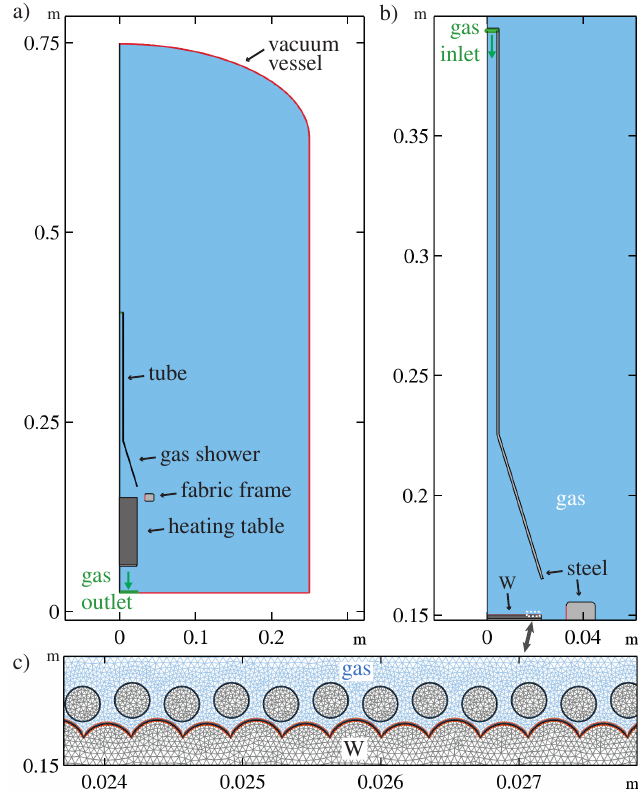
Figure 5. ( a ) Reactor model geometry of the CVD device with a close-up of the gas shower in ( b ) and with a closer look at the fibers of the new layer (floating circles) in ( c ). Below the fibers, the W domain is shown, which consists of the fibers from the previous layer and the CVD-W grown around these fibers (its surface is marked in